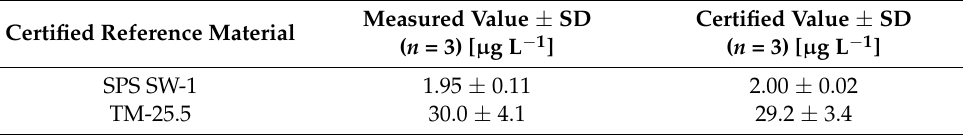
Table 4. Results obtained during the determination of Se(IV) in certified reference